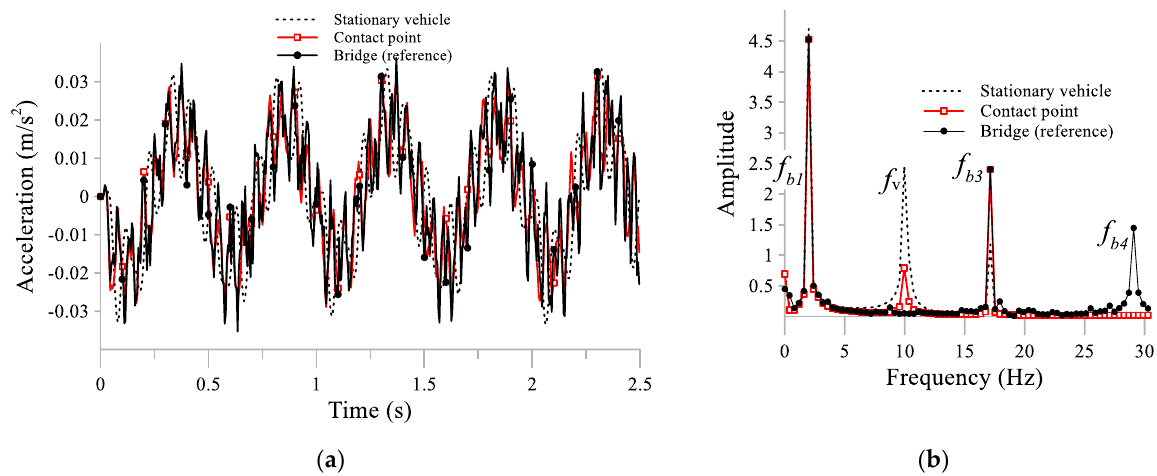
Figure 8. Dynamic response of the stationary vehicle at 10 Hz, along with the contact-point and bridge ( a ) acceleration responses at the mid-span location and ( b ) the acceleration spectra.